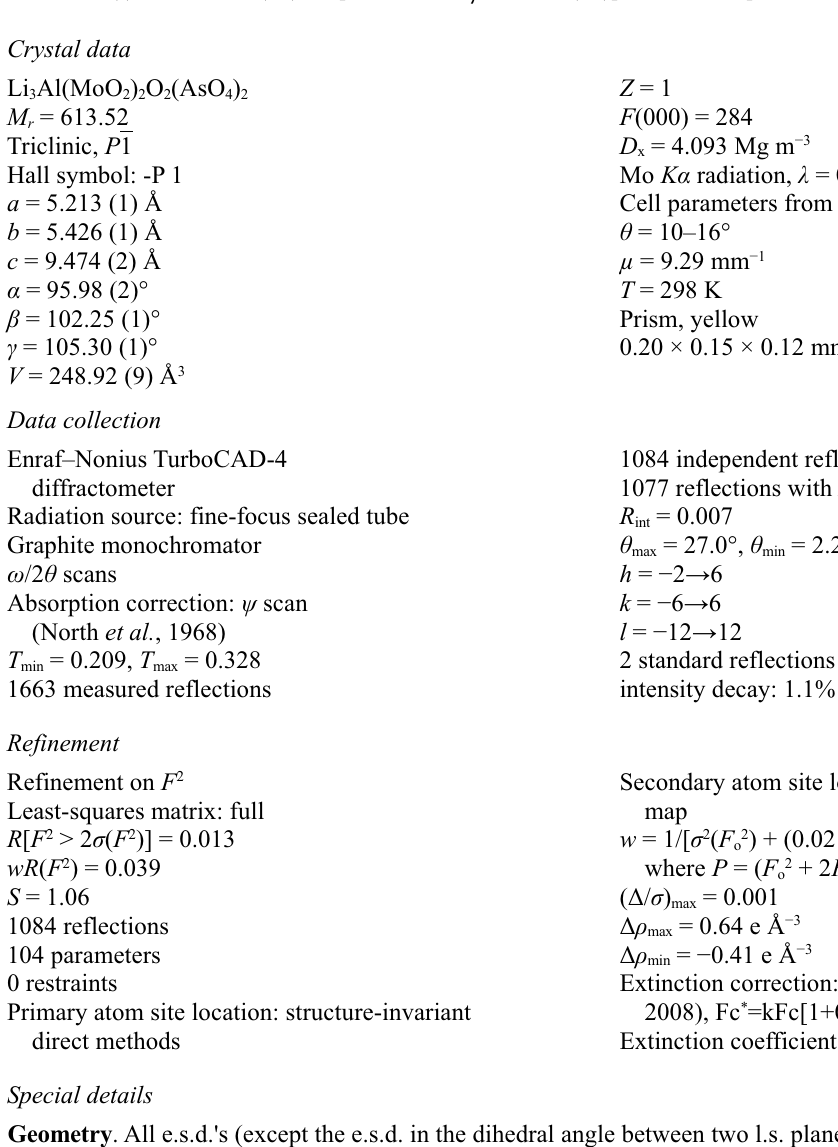
Figure 3 Projection de la structure de Li trilithium(I) aluminium(III) bis[dioxidomolybdenum(VI)] dioxide